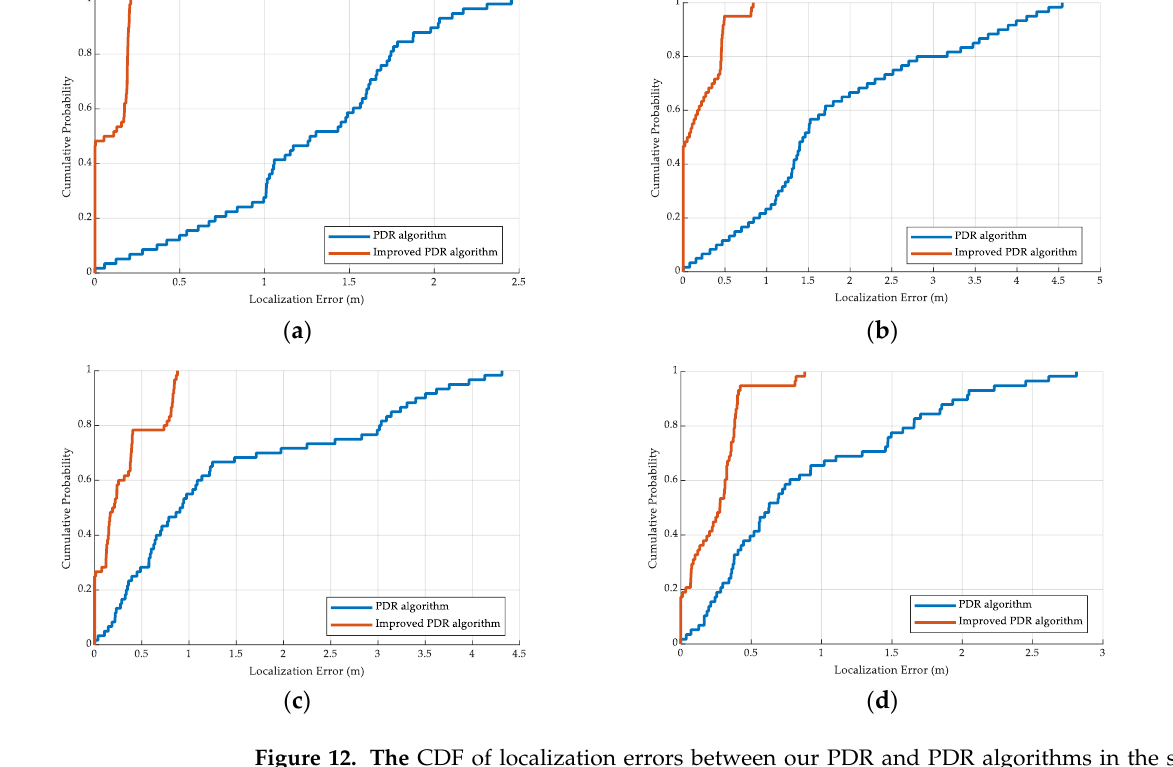
Figure 12. The CDF of localization errors between our PDR and PDR algorithms in the second scene. ( a ) Volunteer #1 with a VivoY85a cell phone. ( b ) Volunteer #2 with a VivoY85a cell phone. ( c ) Volunteer #1 with an Honor60 cell phone. ( d ) Volunteer #2 with an Honor60 cell phone.